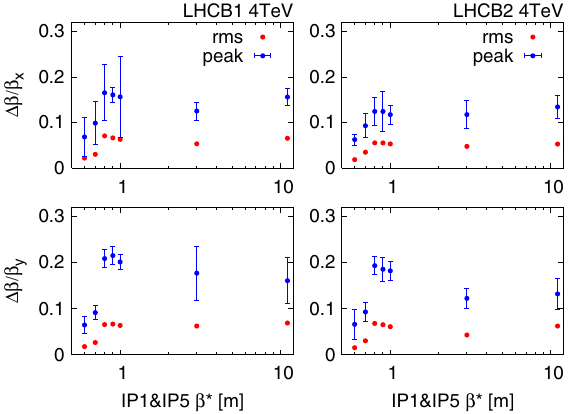
FIG. 9. (cid:1) beating after global correction for (cid:1) (cid:1) (cid:5) 0 : 7 m and after local correction for (cid:1) (cid:1) (cid:6) 0 : 8 m . Beam 1 (left) and beam 2 (right), horizontal (top) and vertical (bottom) plots showing the peak and rms (cid:1) -beating values versus (cid:1) (cid:1) .